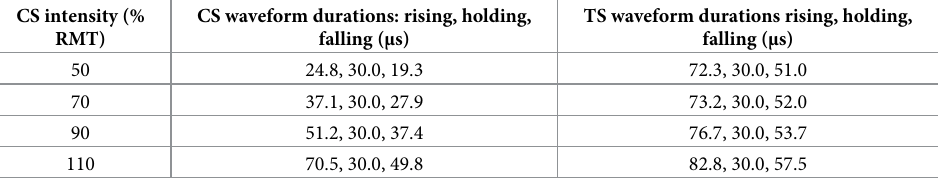
The values represent the duration of three phases of a trapezoidal monophasic waveform: Rising, holding, and falling.